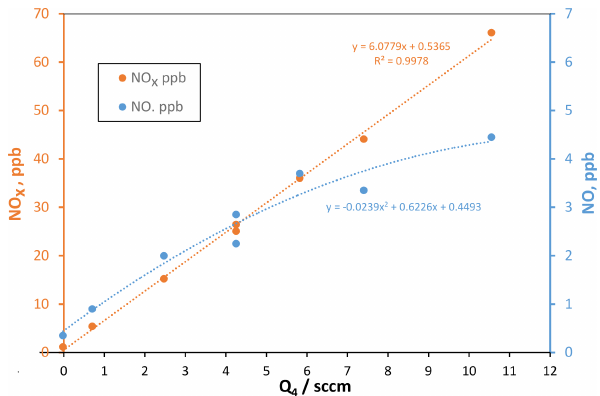
Figure 2. NO x (left axis) and NO (right axis) vs. flow rate Q 4 of HCl-laden flow over NaONO(s). Assuming that the NO x level is related one-to-one to HCl, the HCl mixing ratio in flow Q 4 is 17.6ppmv. sccm: standard cm 3 min − 1 . NO x here includes HONO.